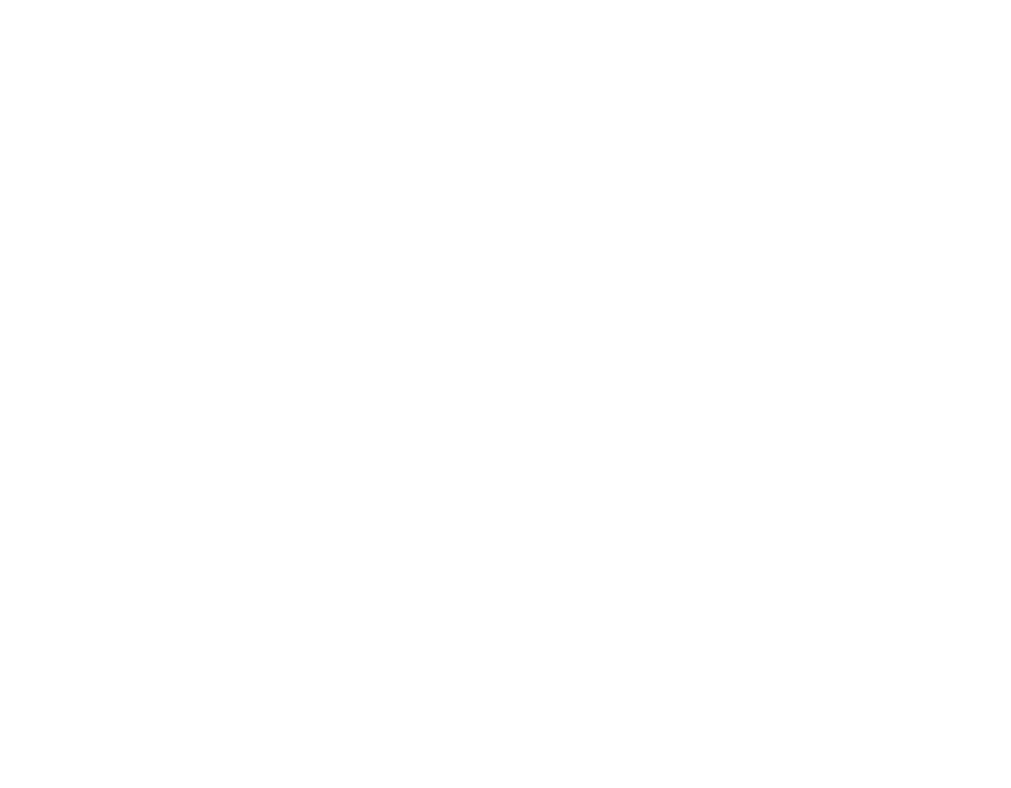
the awareness contrast (aware versus unaware errors). Four major brain areas were involved in both contrasts: bilateral thalamus, supplementary motor area, rostral cingulate, and in bilateral parietal lobule. Furthermore, overlapping activations were found in the precuneus and lateral occipital